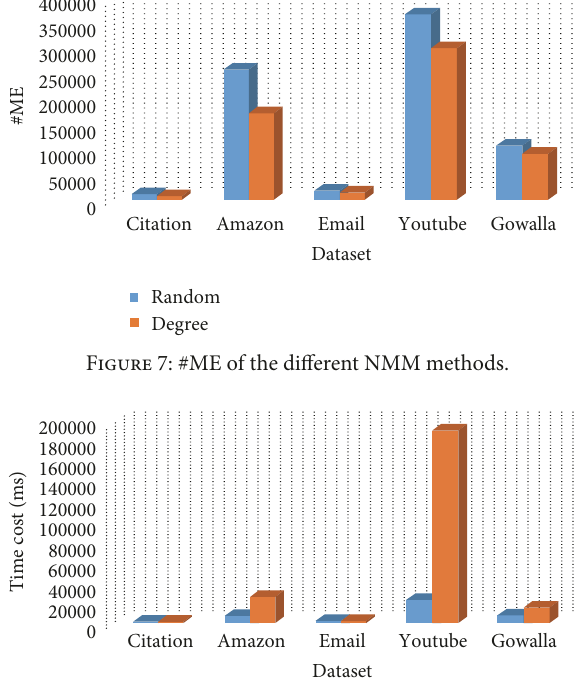
Table 4: Selected features.